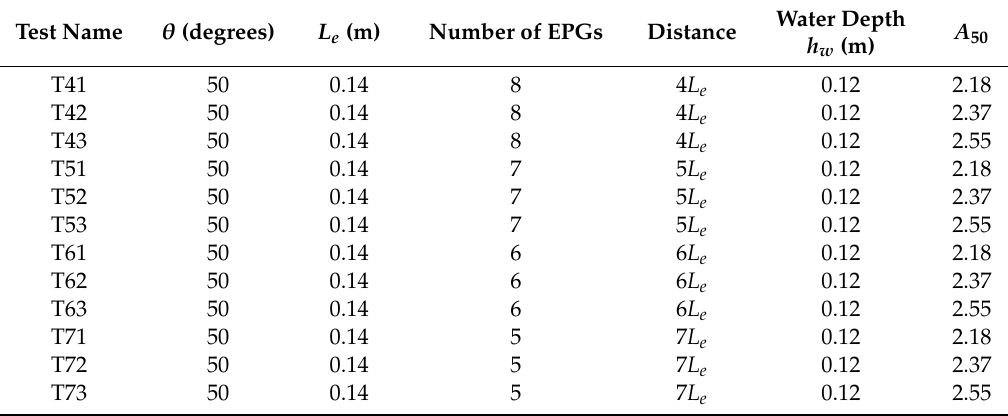
Figure 3. A view of the enhanced permeable groins installed in the bend for the experiment with the space 7 L e before ( a ) and after ( b ) scouring. Table 1. Description of experimental tests.